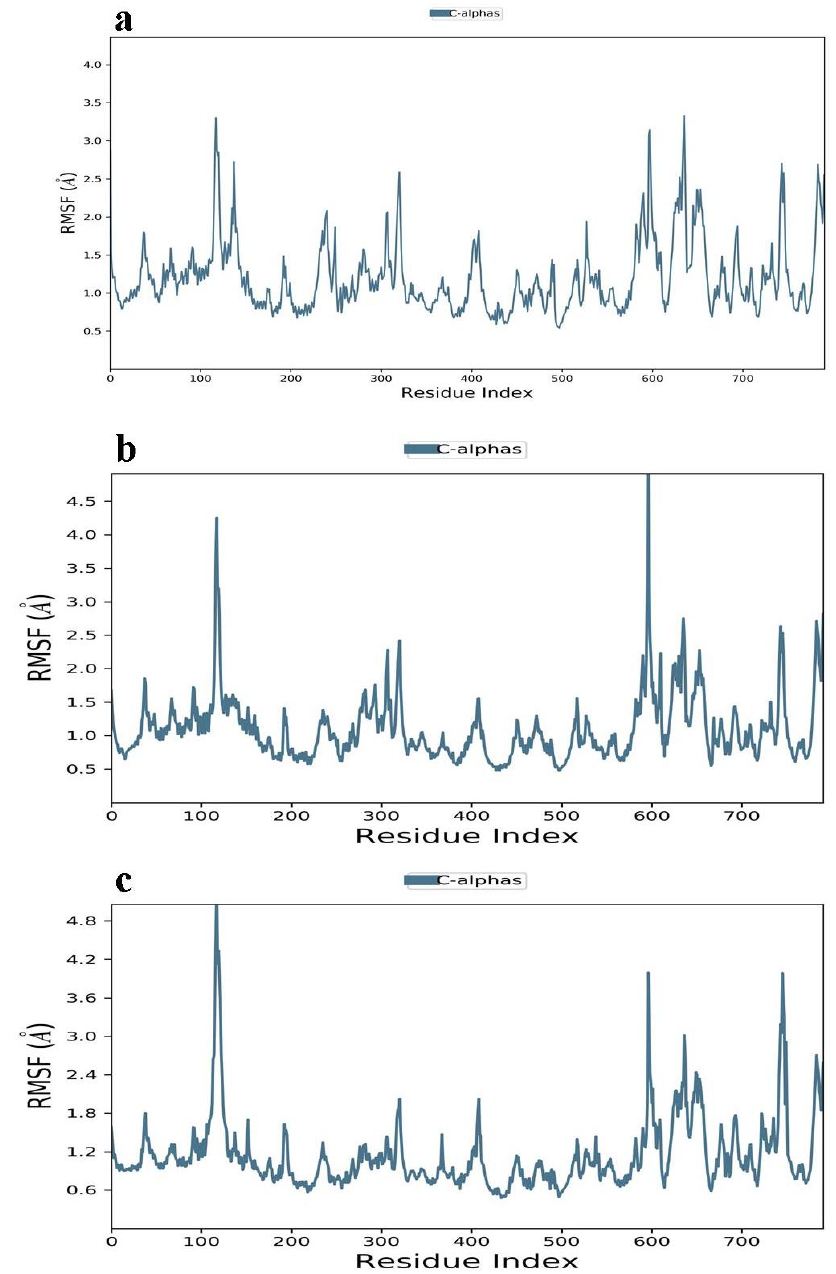
Figure 7. ( a – c ) RMSF plot of compounds showing stability index. ( a ) Ononin/30S ribosomal protein S4 complex; ( b ) Sanggenon A/4-hydroxybenzoate decarboxylase subunit C; ( c ) Andromedo- toxin/Oligopeptide Binding Protein.